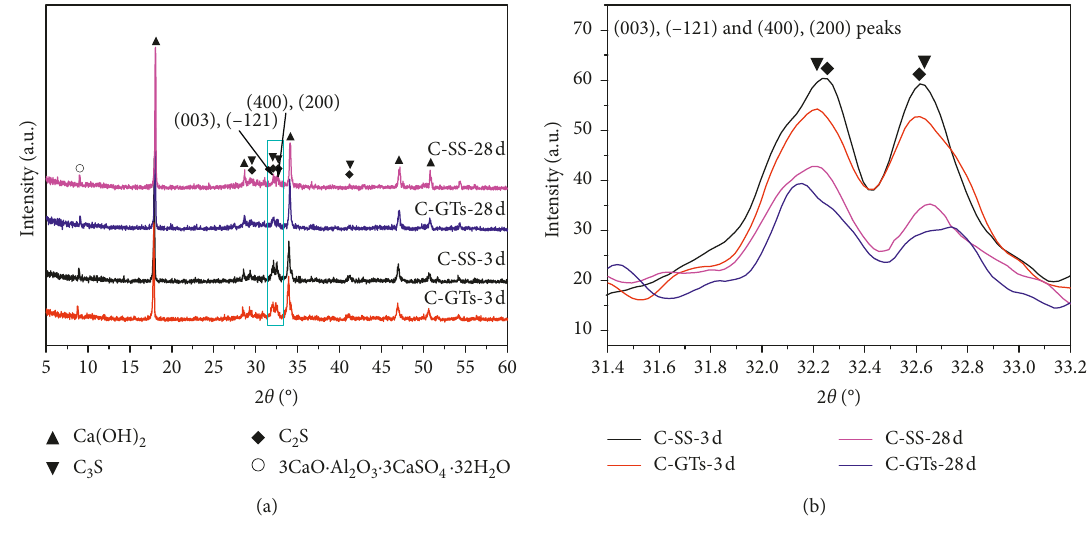
Figure 7: XRD patterns of pastes after 3 days and 28days.